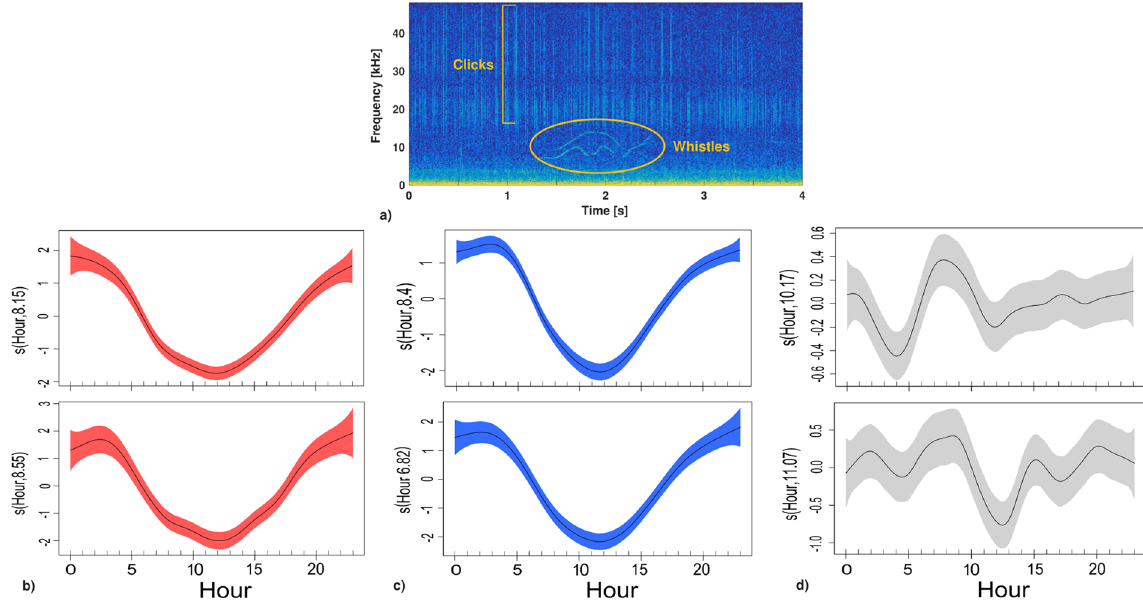
Figure 3. Daily pattern. ( a ) Spectrogram (nfft = 2048; overlap = 50; Hann window) of dolphin vocalizations investigated: clicks and whistles. ( b ) Click probability of presence for the automatic analysis (in red) as a function of hour of day (GAM model, 2005: N = 3736, R 2 = 0.215, Deviance explained = 19.7%, Hour: χ 2 = 619.7, P < 0.001; 2006: N = 1758, R 2 = 0.266, Deviance explained = 24.1%, Hour: χ 2 = 349.3, P < 0.001). ( c ) Click probability of presence for the manual analysis (in blue) as a function of hour of day (GAM model, 2005: N = 3736, R 2 = 0.297, Deviance explained = 23.2%, Hour: χ 2 = 914.3, P < 0.001; 2006: N = 1758, R 2 = 0.337, Deviance explained = 27.7%, Hour: χ 2 = 459, P < 0.001). ( c ) Whistle probability of presence for the manual analysis (in grey) as a function of hour of day (GAM model, 2005: N = 3736, R 2 = 0.0084, Deviance explained = 0.883%, Hour: χ 2 = 35, P < 0.001; 2006: N = 1758, R 2 = 0.0194, Deviance explained = 2.1%, Hour: χ 2 = 37.53, P < 0.001). ( b–d ), ( top ) 2005; ( bottom ) 2006; ( shaded areas ) 95% confidence